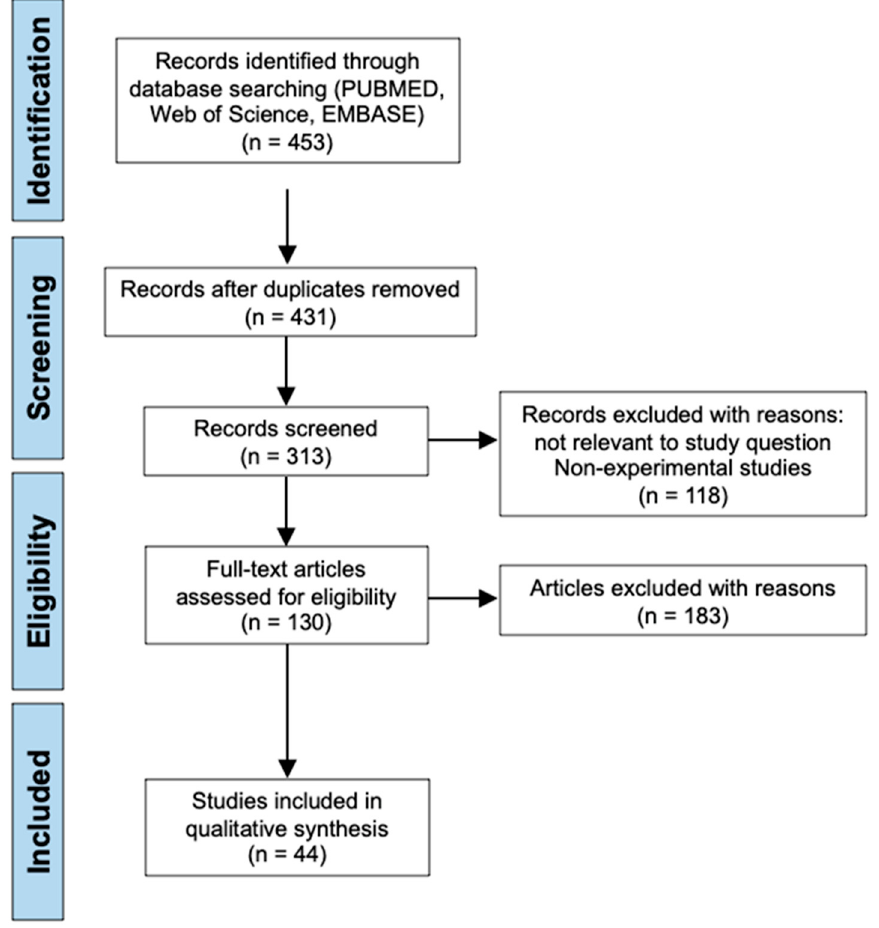
Figure 1. PRISMA flow chart illustrating the literature search process and screening of papers included in this systematic review.